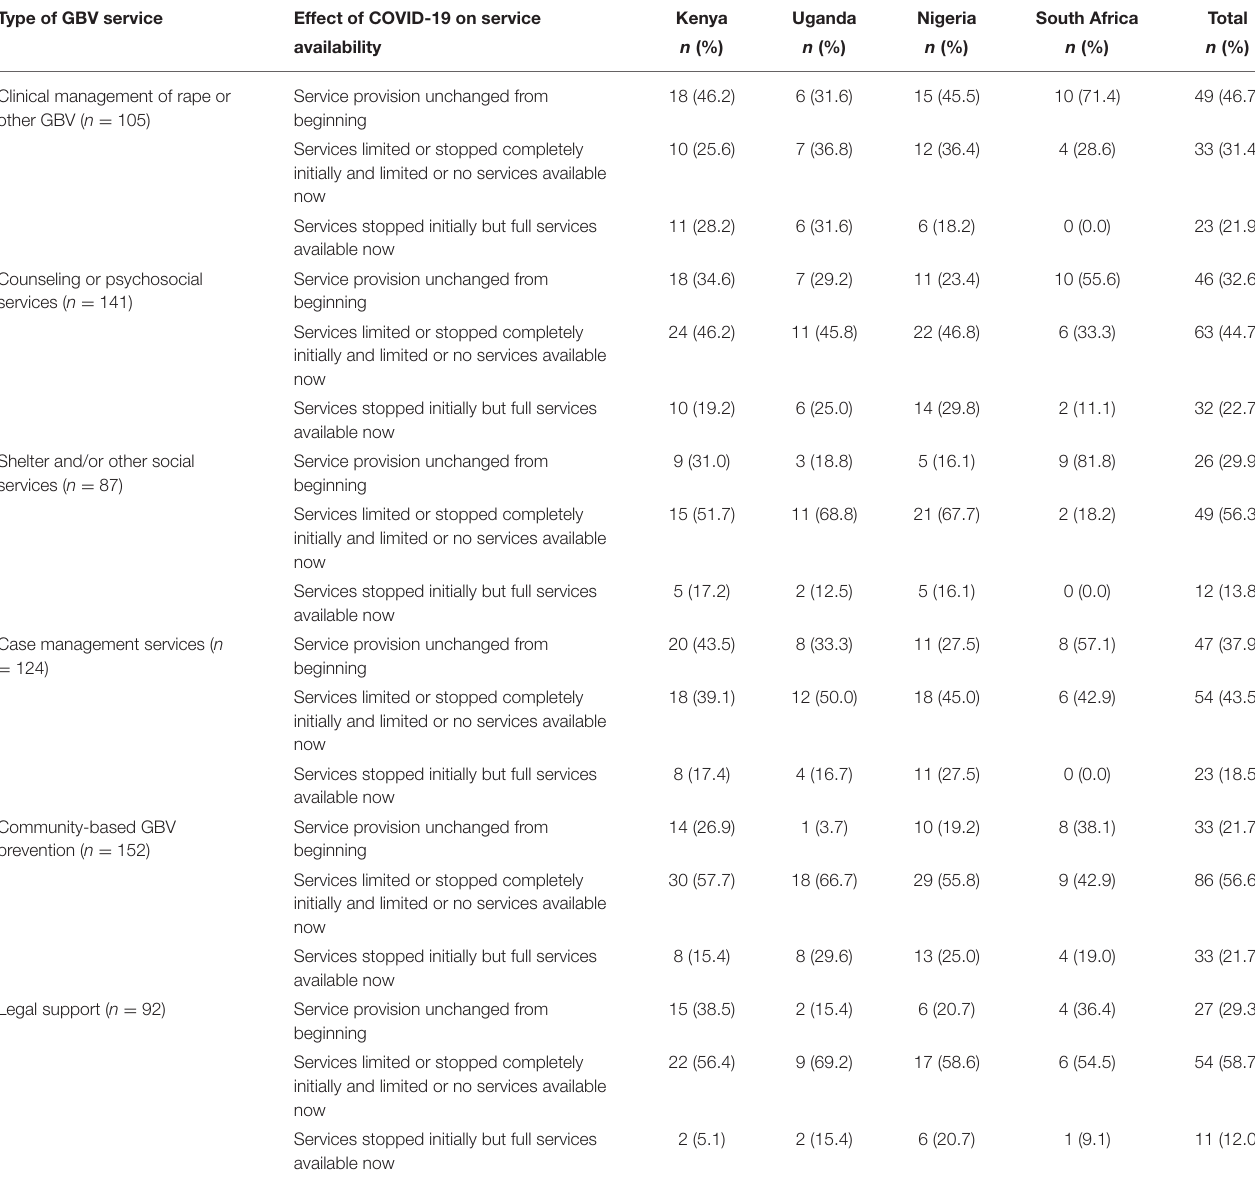
TABLE 3 | Changes in provision of GBV prevention and response services resulting from the COVID-19 pandemic and subsequent lockdown